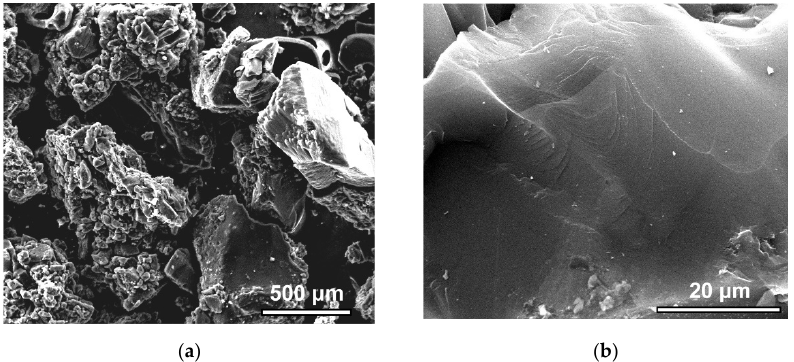
Figure 5. SEM images of the SiC ‐ AC surface at a scale bar of 500 μ m ( a ) and 20 μ m ( b ).